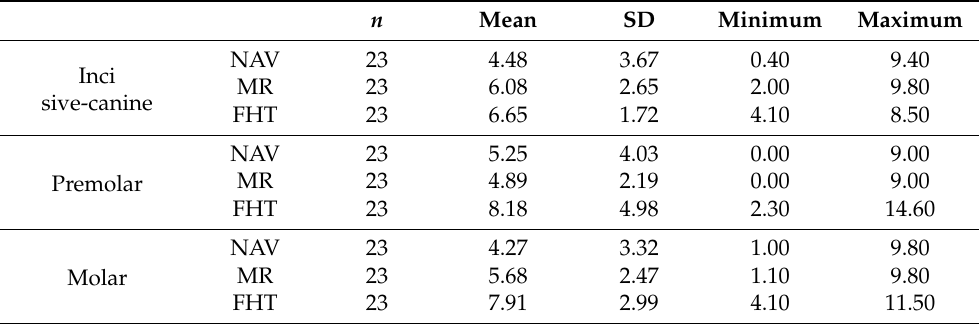
Table 6. Descriptive deviation values at angular level ( ◦ ) of the orthodontic micro-screws placed by using conventional freehand technique, mixed reality technique and computer-aided static navigation technique study groups in the incisive-canine, premolar and molar dental sector.